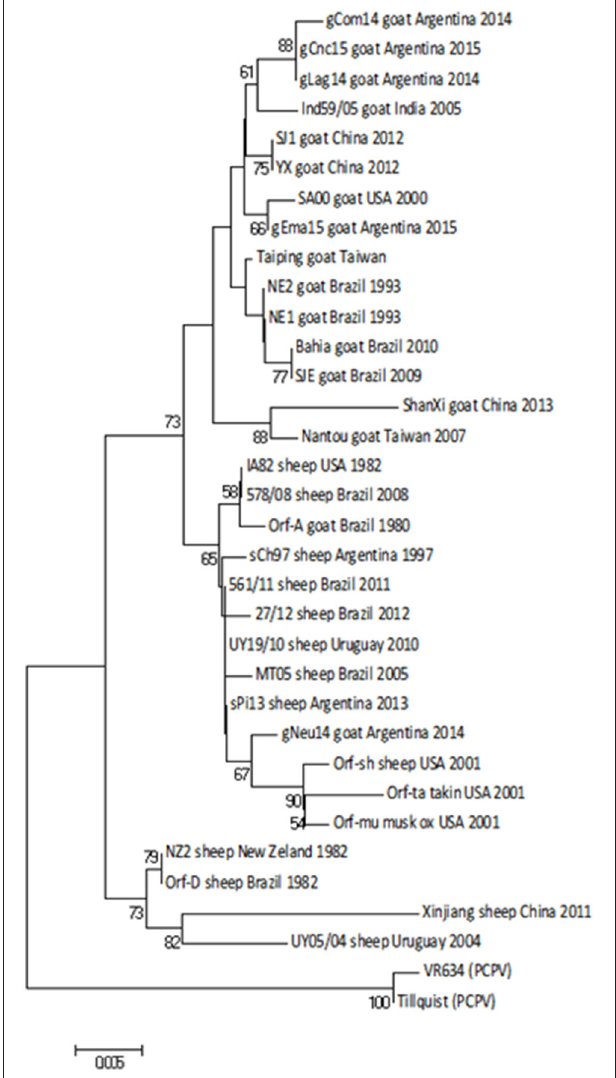
FIGURE 3 | Phylogenetic analysis based on nucleotide sequence of orf011 . The phylogenetic relationship was constructed by the Neighbor-Joining algorithm using MEGA 6.0 software. Numbers at nodes represent % of one thousand bootstrap replicates. The scale bars are expressed in relative nucleotide sequence